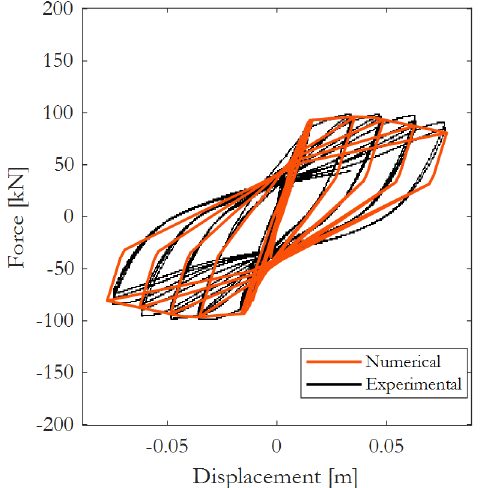
Figure 8. Comparison between numerical and experimental results of the SLD specimen by Verderame et al.